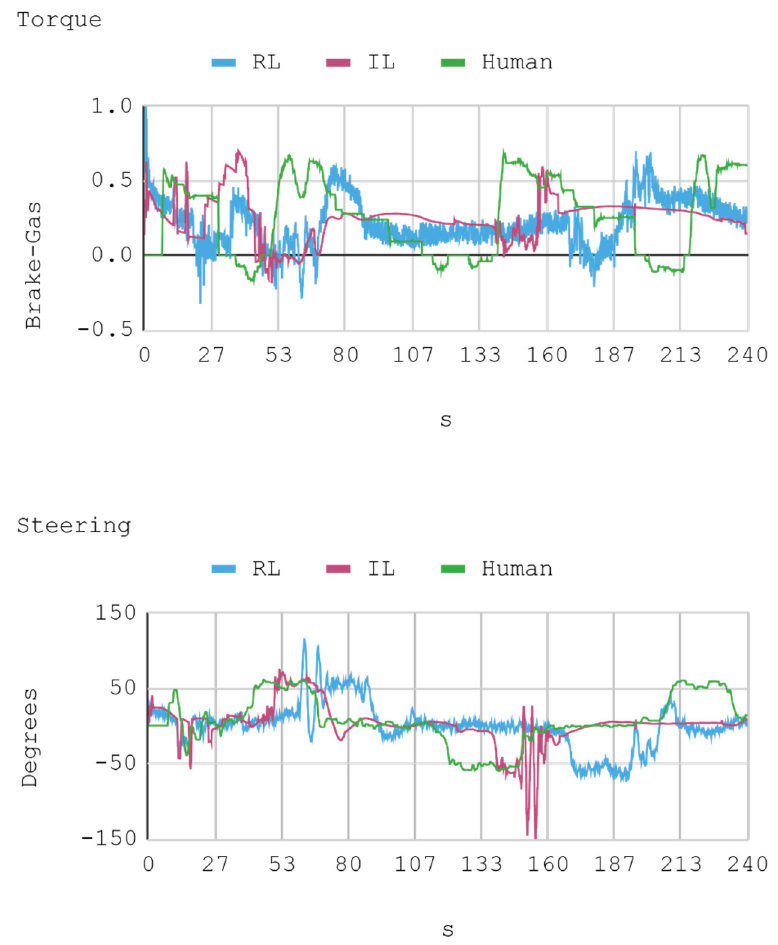
Figure 8. Case 1. Automobile torque and steering.